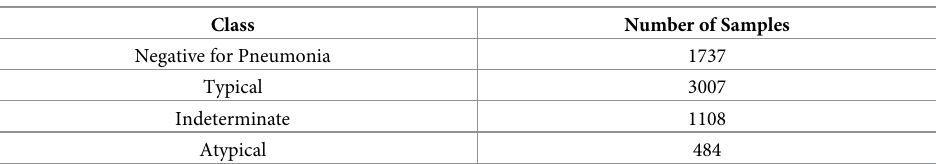
Table 1. Distribution of image classes.